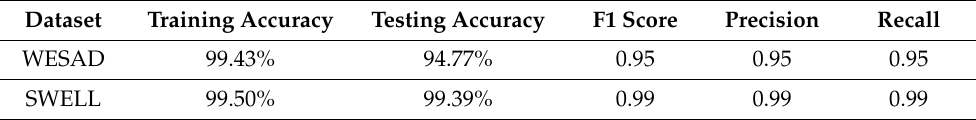
Table 4. Overall performance results attained by the proposed image-encoding-based deep neural network on both WESAD and SWELL